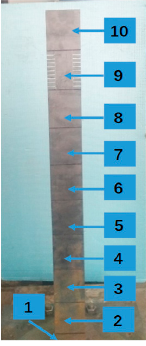
Figure 9. Single damage diagram of cantilever beam.